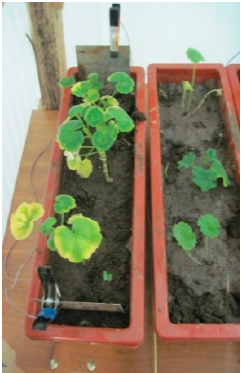
Figure 2. Pilot plant for the application of phyto-electroremediation (phyto-ER).